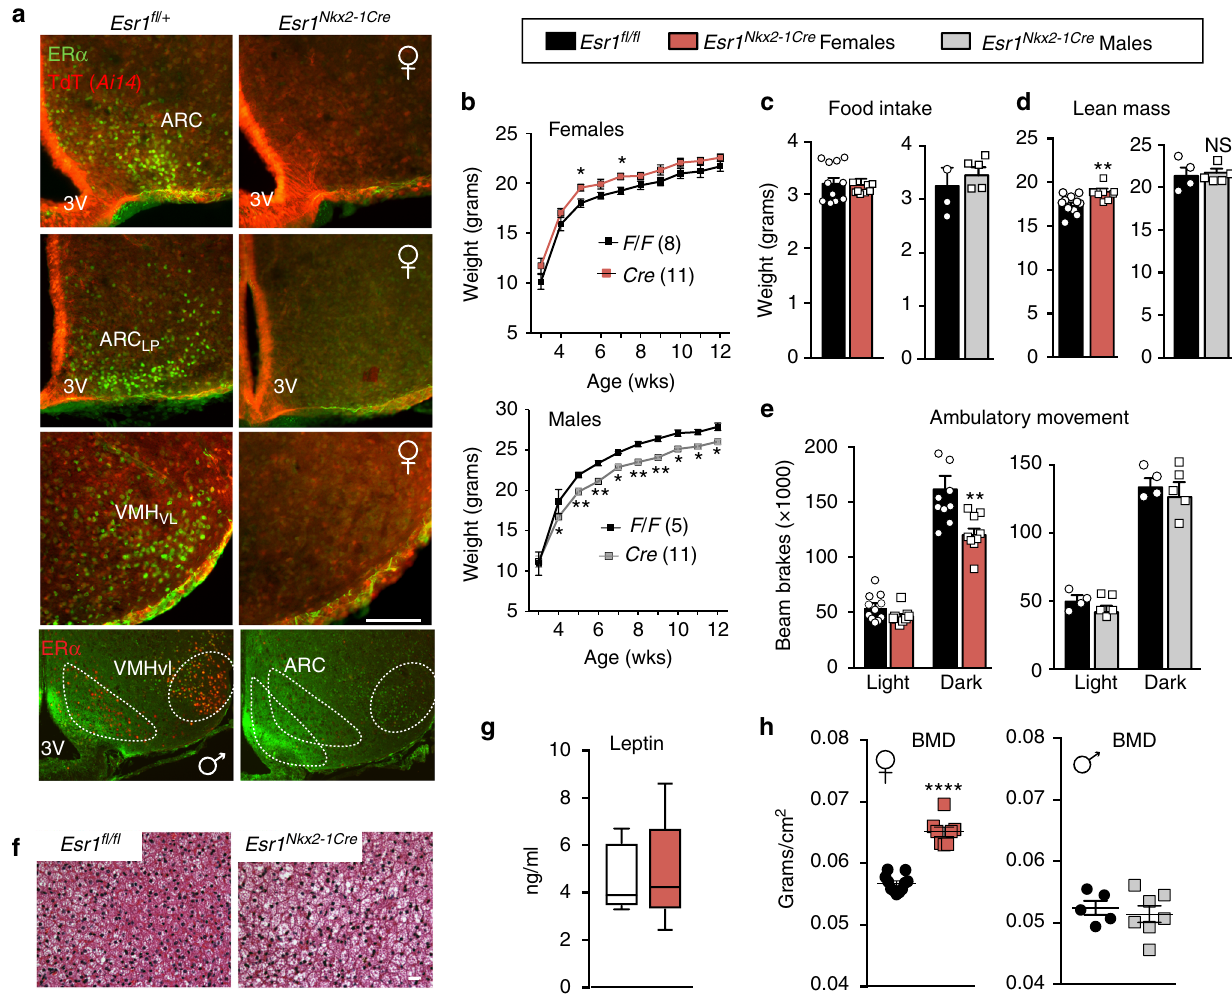
Fig. 1 Ablating ER α in MBH impairs energy expenditure and increases bone density. a Immunohistochemistry of ER α (green) or native TdTomato (TdT (Ai14); red) on coronal brain sections (scale bar = 100 µ m) of Esr1 fl / + ; Ai14 fl / + ; Nkx2-1Cre (control) or Esr1 fl / fl ; Ai14 fl / + ; Nkx2-1Cre (mutant) from females or males (bottom panels). Lp lateroposterior. Fl/ + = heterozygous for Esr1 fl oxed allele. b Body weight curves of control (black line) or mutant females (red line) ( F 1,250 = 57.01, p < 0.0001) and males (grey line) ( F 3,316 = 25.39, p < 0.0001) fed on standard chow from 3 weeks of age. c Daily food intake